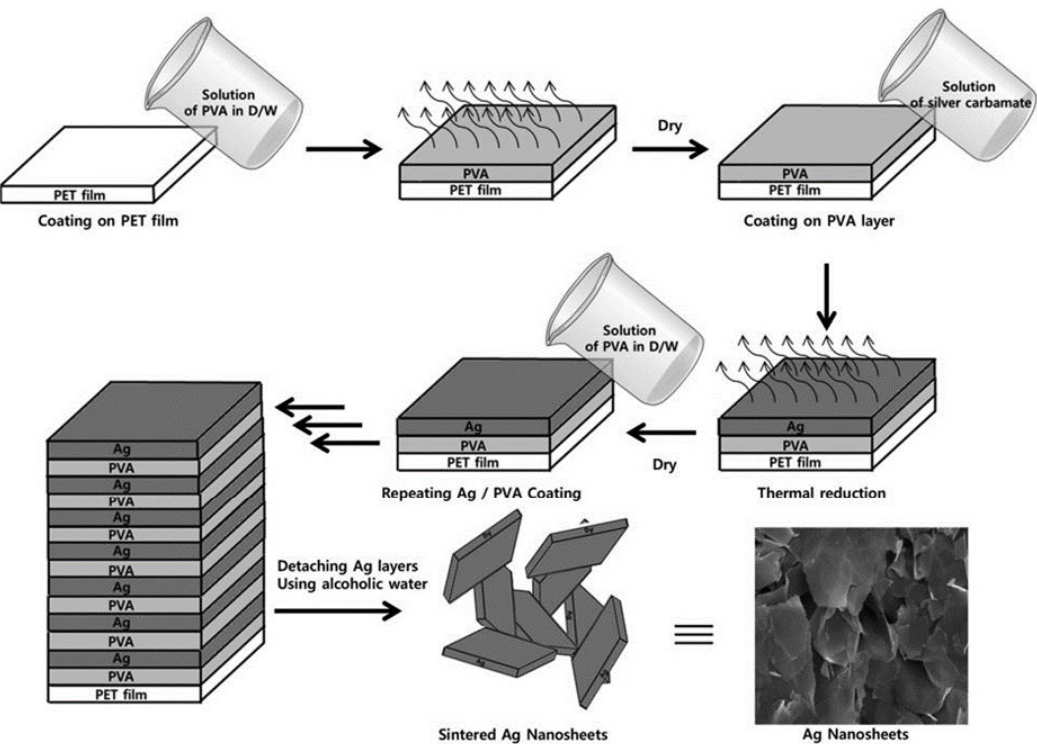
Fig. 11: Schematic procedures for preparation of sintered Ag nanosheets using coating process. Reproduced with permission from ref.19, copyright 2015, Elsevier.